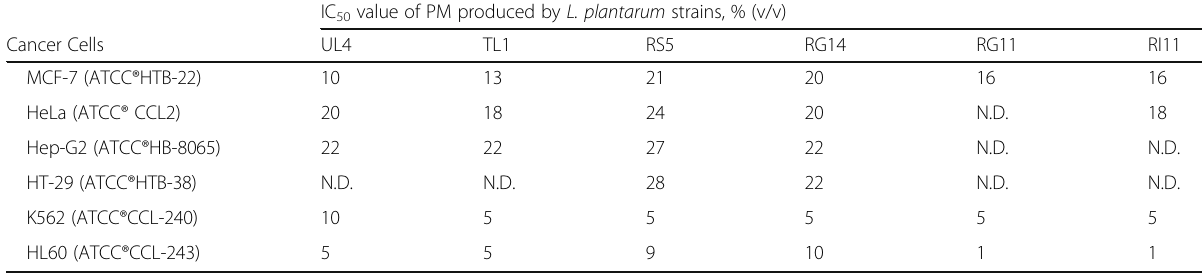
Table 1 IC 50 values of PM produced by six strains of Lactobacillus plantarum on various cancer cells IC 50 value of PM produced by L. plantarum strains, % (v/v) Cancer